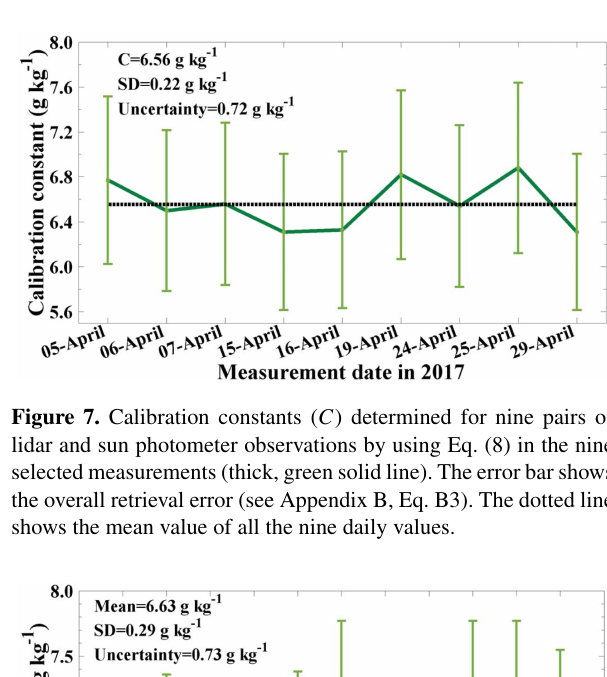
differences are shown as black dots. The mean difference is represented by a blue horizontal line and the value is 0.06 g kg − 1 . The σ values in this figure denote the standard deviations of the differences. In Fig. 10b, the relationship be- tween the water vapor measurements from Polly XT and ra- diosonde is shown. Data of the WVMR differences larger than 2 σ are not considered. The thresholds ± 2 σ are shown by the dark green horizontal lines in Fig. 10a as well. After the screening, 95.2 % of data were selected for calculations. The remaining 4.8 % data were also marked with red dots in Fig. 10b and are not used for fitting. According to the results, we can find a slope of 1.01 and a R 2 of 0.99, which means that the agreement of WVMR measurements from Polly XT and radiosonde is very